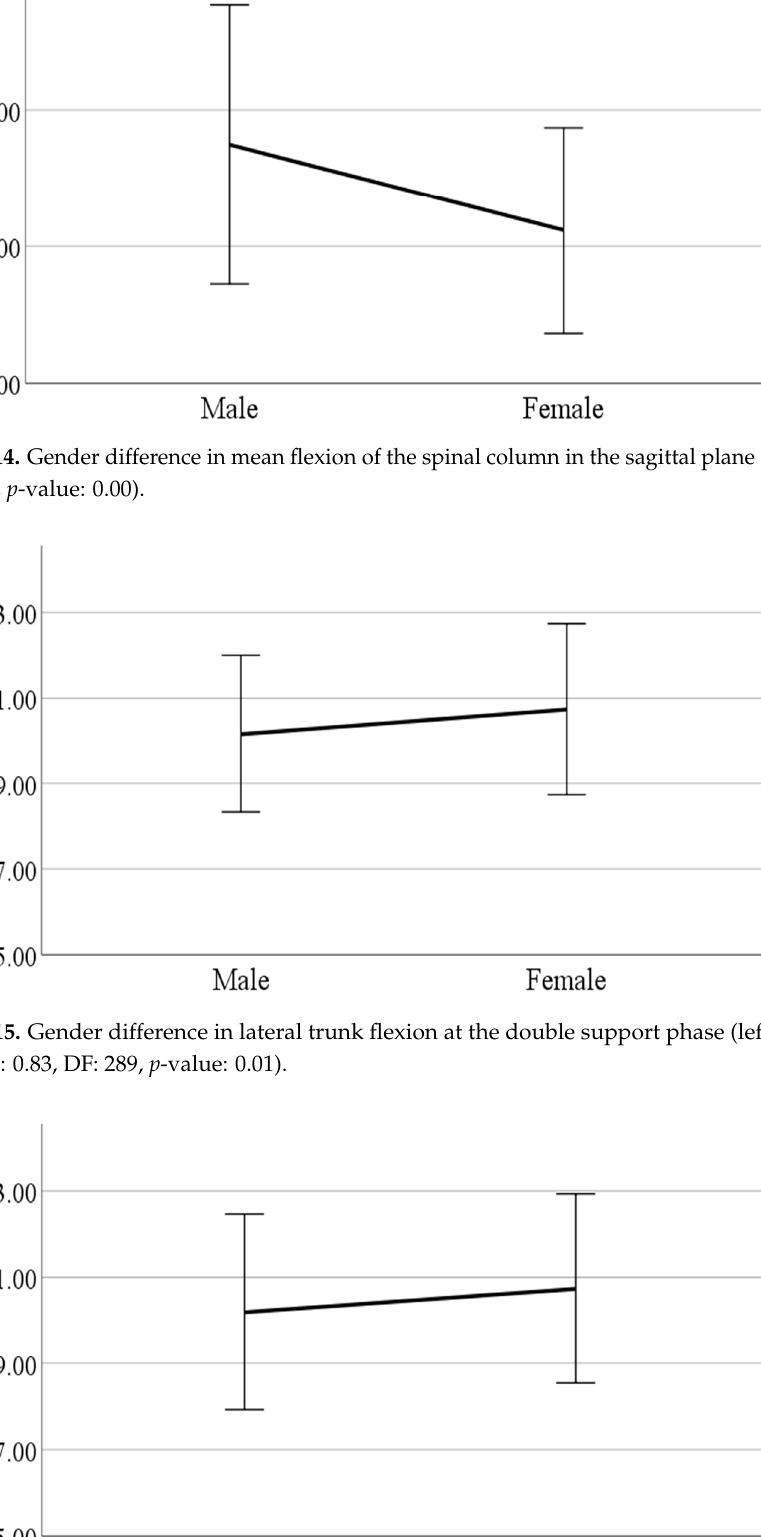
Figure 13. Gender difference in the flexion of the spinal column in the sagittal plane at toe-off (F value: 17.11, DF: 289, p -value: 0.00).